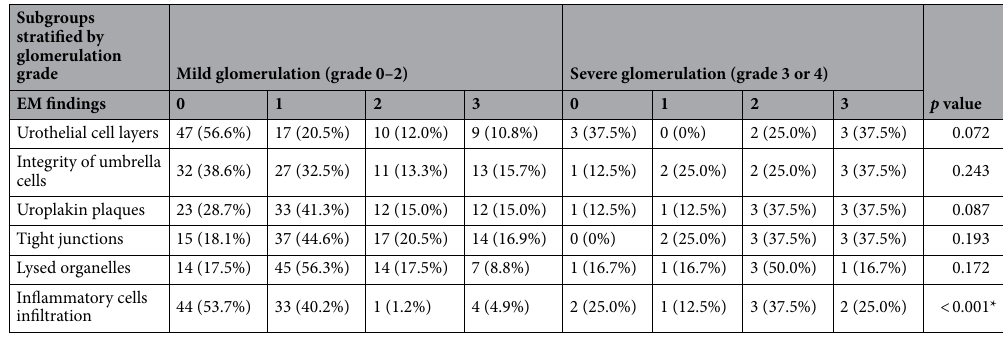
Table 2. Differences in electron microscopic (EM) findings between non-Hunner’s interstitial cystitis patient. * p < 0.05 by chi-square